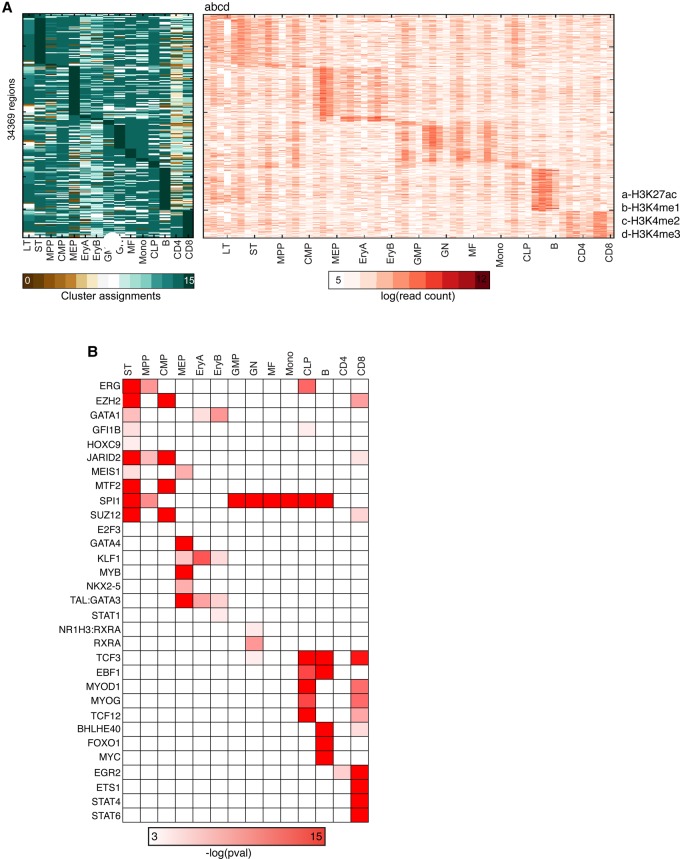
Cell-type–specific regions and decision points identified by CMINT in the hematopoietic hierarchy. (A, left) Regions that uniquely belong to module 15 in Supplemental Figure S5 and their cluster assignments in other cell types; (right) enrichment of each histone modification in the regions that uniquely belong to Module 15 in Supplemental Figure S5. (B) ORegAnno cis-regulatory element enrichment for factors (left) enriched in regions uniquely assigned to module 15 in each of the cell types indicated on top.